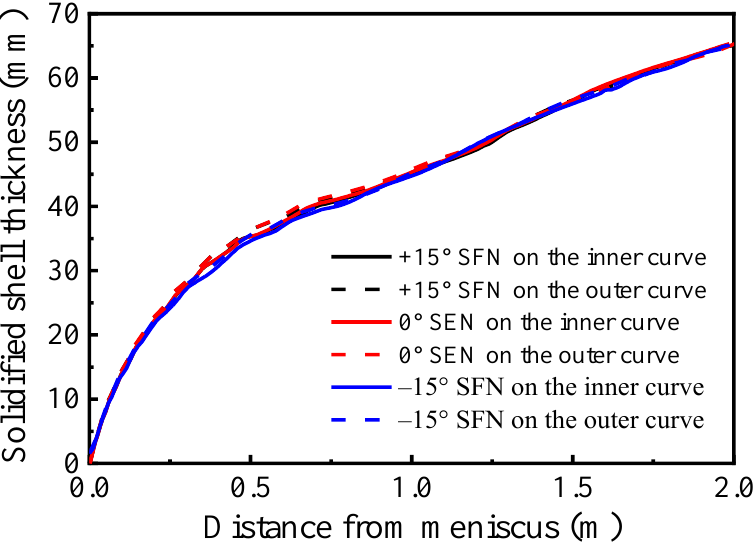
Figure 15. Shell thickness distributions along casting speed direction on the plane Y = 0 m with M- EMS.